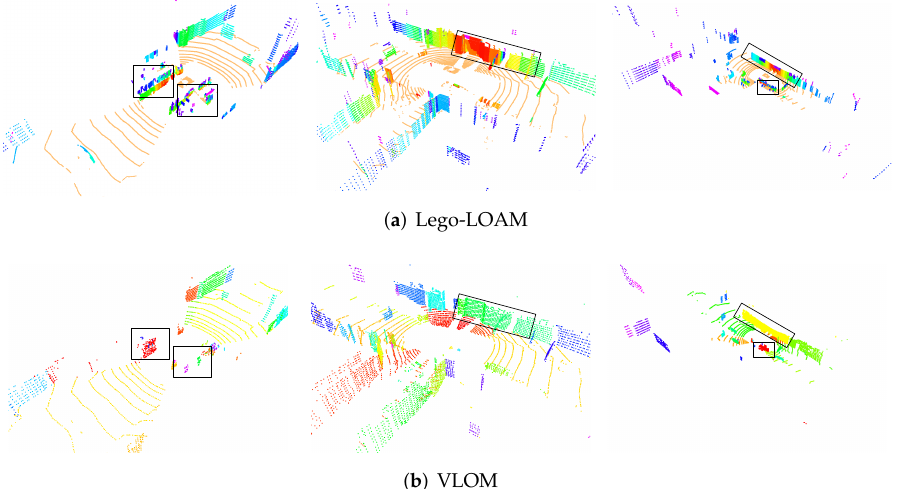
Figure 7. Segmentation results of Lego-LOAM ( a ) and VLOM ( b ). The various colors represent different planes. The rectangle in the image indicates some differences between Lego-LOAM and VLOM. The continuous color in Lego-LOAM indicates that each plane is divided into several parts.